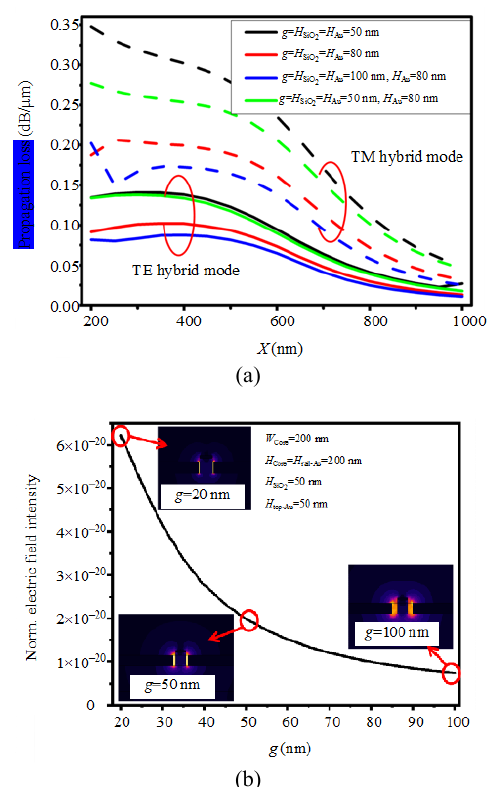
Fig. 4 Calculation of (a) modal propagation loss vs WG geometry and (b) dependence of the electric field intensity on nano-slot ( g